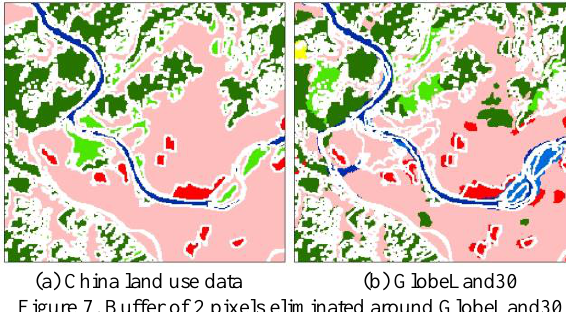
Figure 7. Buffer of 2 pixels eliminated around GlobeLand30